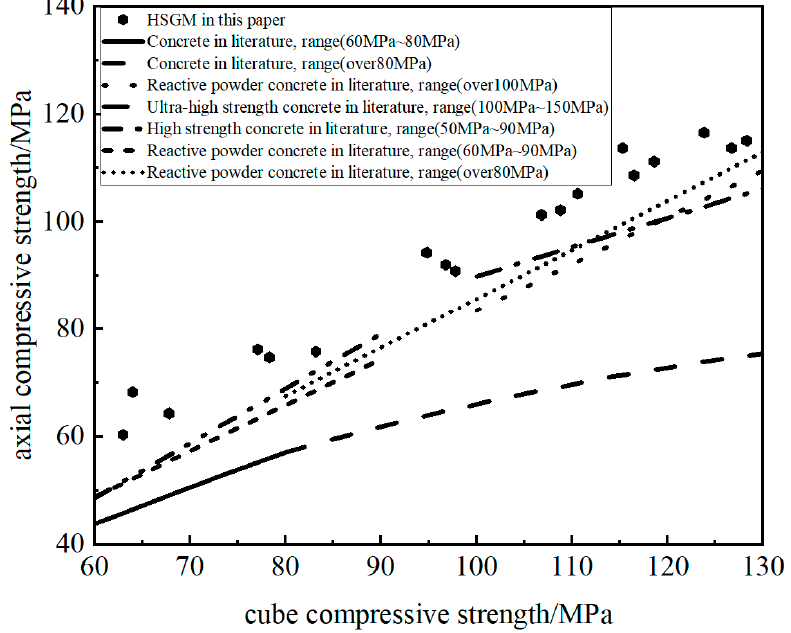
Figure 6. The relationship between axial strength and cubic strength of grout materials and concrete.